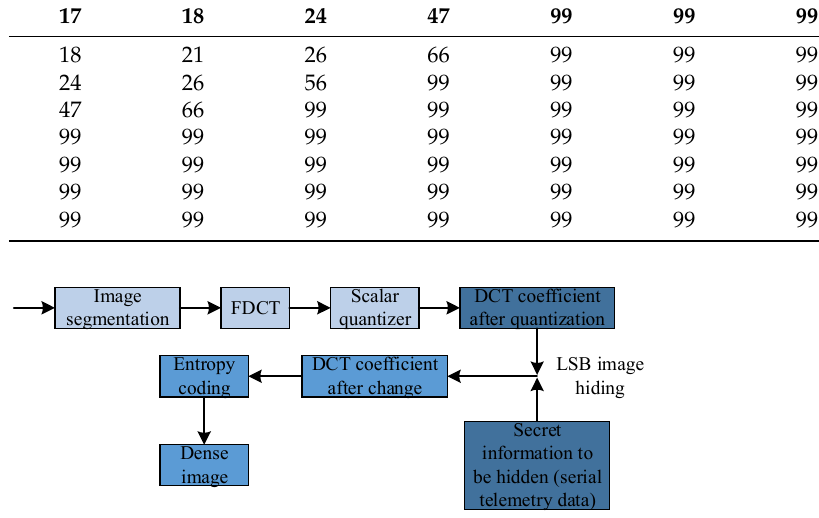
Figure 12. The final optimization model of image coding hiding.